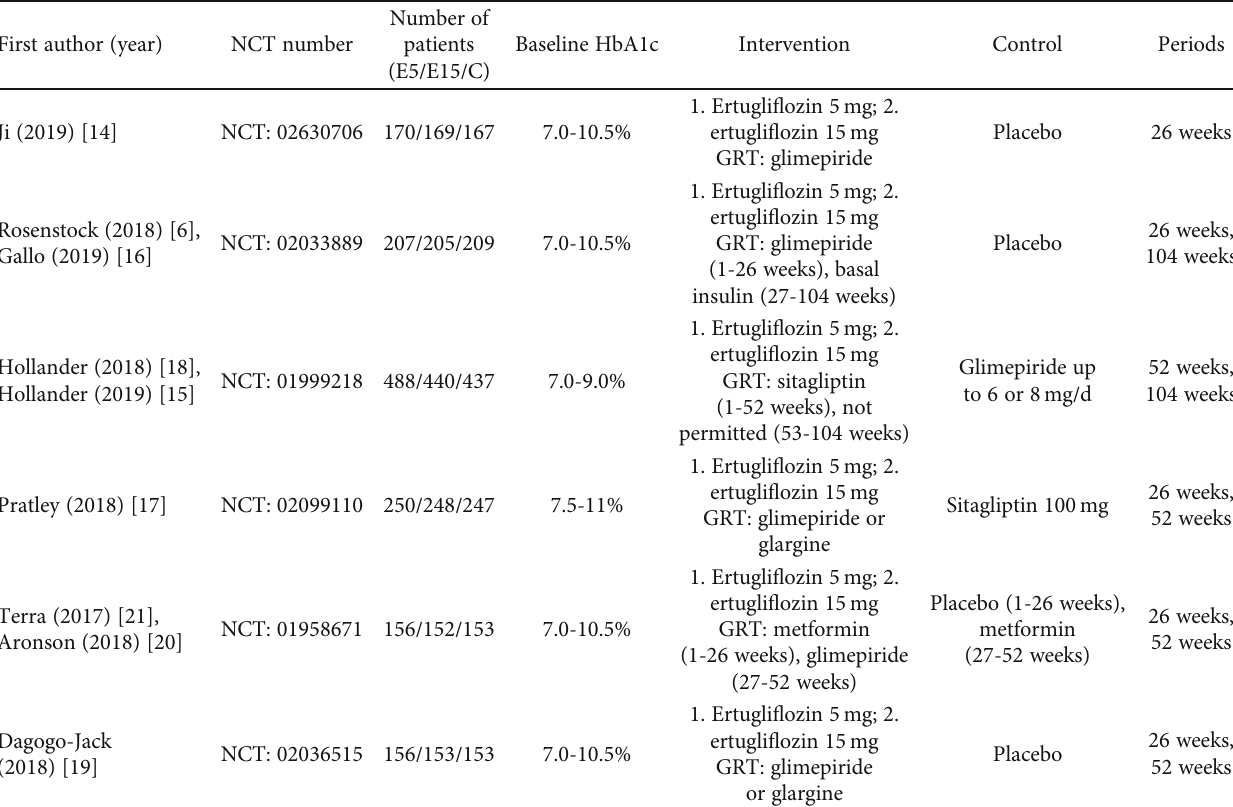
Table 1: Characteristics of studies included in the meta-analysis.